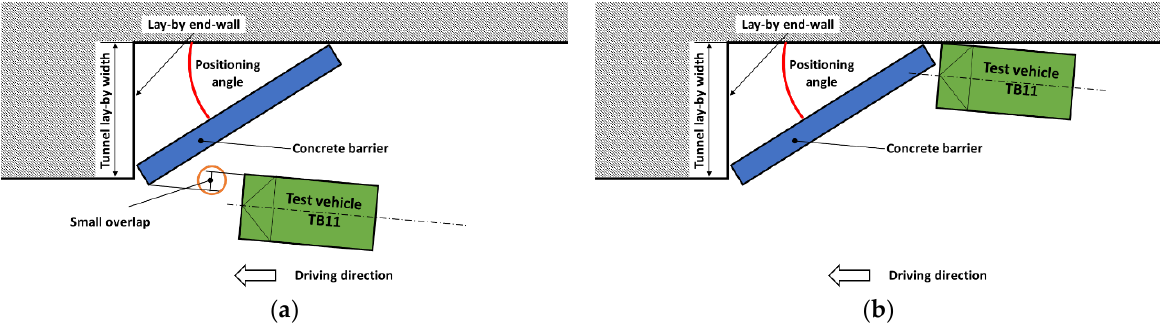
Figure 14. Crash configurations for angled concrete barriers. ( a ): Small overlap of the vehicle; ( b ): Impact into the transition of the concrete barrier and tunnel lay-by side wall.